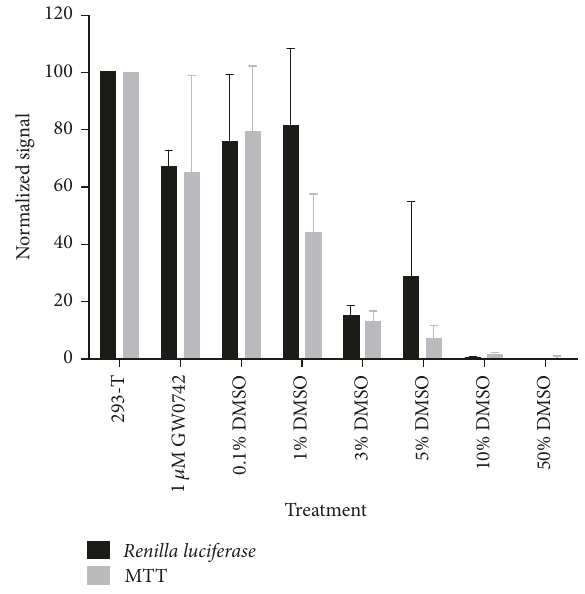
Figure 3: Development of a cytotoxic parameter. Comparison between the Renilla reporter expression with the MTT cytotoxicity signal in different DMSO concentrations (0.1%, 1%, 3%, 5%, 10%, and 50%) in order to validate the Renilla reporter expression as an indirect cytotoxicity parameter. One micromolar GW0742 diluted in DMSO, with a final concentration of 1% DMSO, was used as the positive control in the screening. Statistical analyses proved that our indirect cytotoxic parameter ( Renilla reporter expression) can be used to identify cytotoxic compounds as well as the MTT cytotoxicity assay. Through analyzing the 2-way ANOVA statistics, there is no statistical difference (ns) between the two types of experiments, and the effect of the DMSO concentration was considered extremely significant according to GraphPad Prism. Followed by Sidak’s multiple comparison test, the toxicity increases in concentrations above 3% of DMSO with statistical significance. Data are the mean ± SD ( 𝑛 = 4 independent